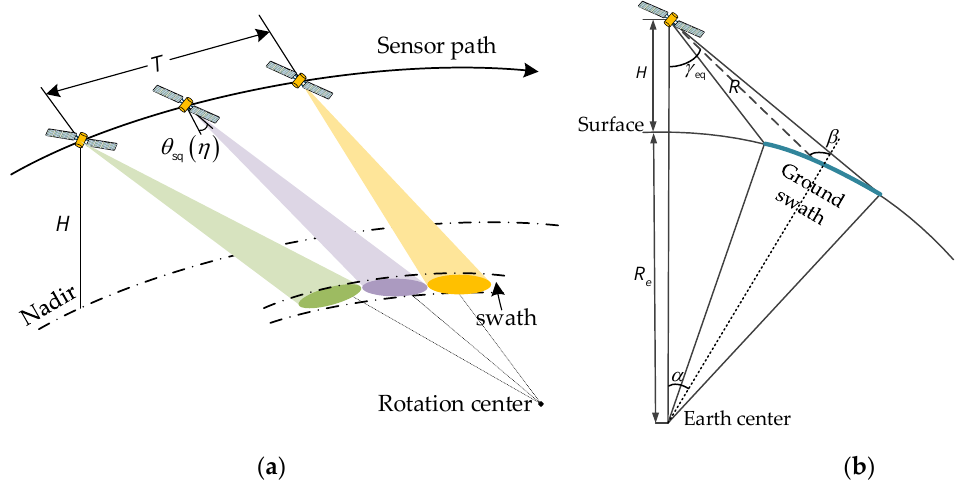
Figure 1. Geometric model of spaceborne squint sliding-spotlight SAR. ( a ) Squint-looking geometry; ( b ) side-looking geometry.